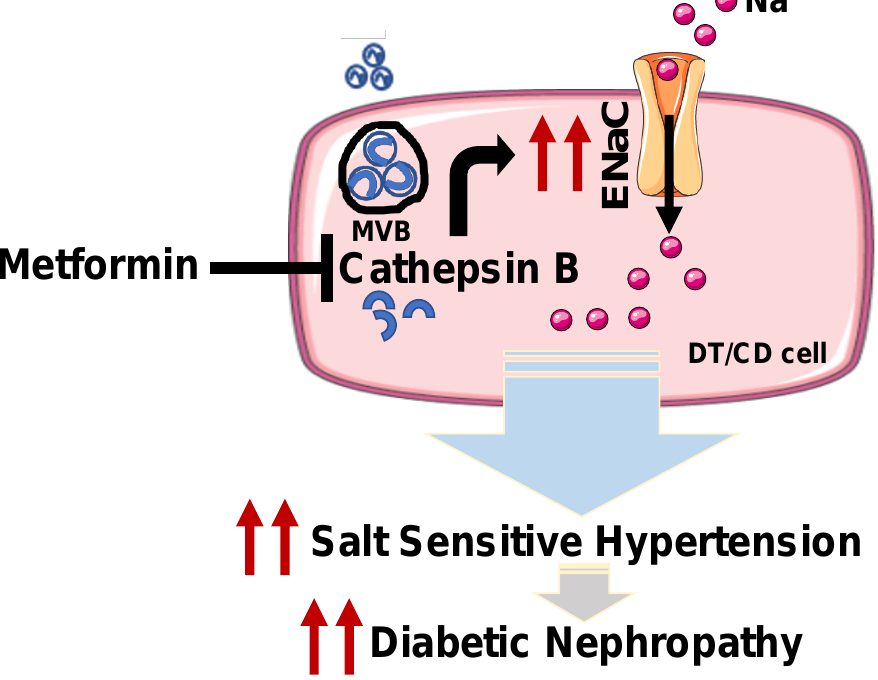
Figure 8. Mechanistic model showing a putative role for metformin in inhibiting renal NCC and ENaC activation and reducing blood pressure in the diabetic kidney. An increase in cathepsin B mediated proteolysis of ENaC alpha in distal tubule (DT) and collecting duct (CD) cells, contributes to the development of salt-sensitive hypertension in the diabetic kidney. Hypertension exacerbates the development of diabetic nephropathy. Metformin attenuates Cathepsin B levels in the kidneys and in EVs to alleviate salt-sensitive hypertension in the diabetic kidney. In addition, metformin reduces the density of ENaC at the luminal membrane. MVB refers to multivesicular